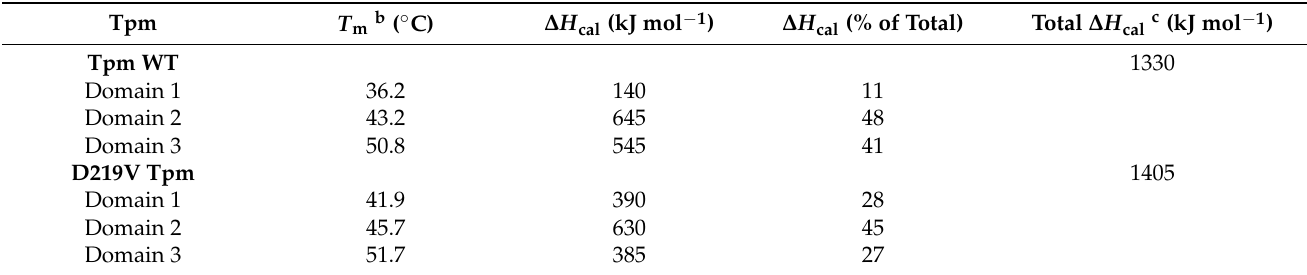
Table 1. Calorimetric parameters obtained from the DSC data for individual thermal transitions (calorimetric domains) of WT Tpm and Tpm with mutation D219V a